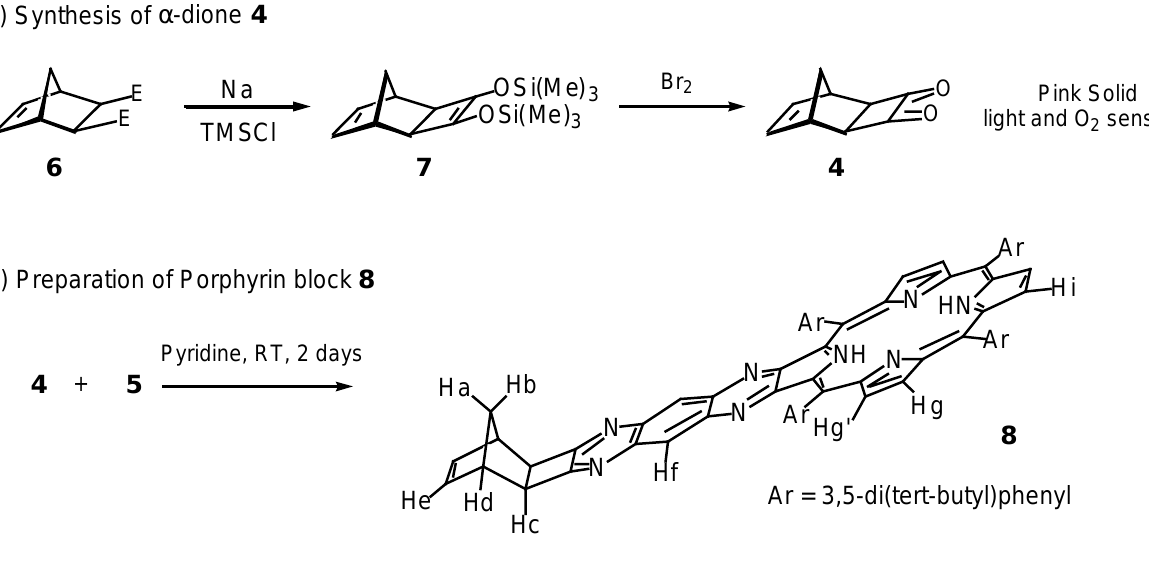
Figure 1: 1 H-NMR spectrum (300 MHz, CDCl